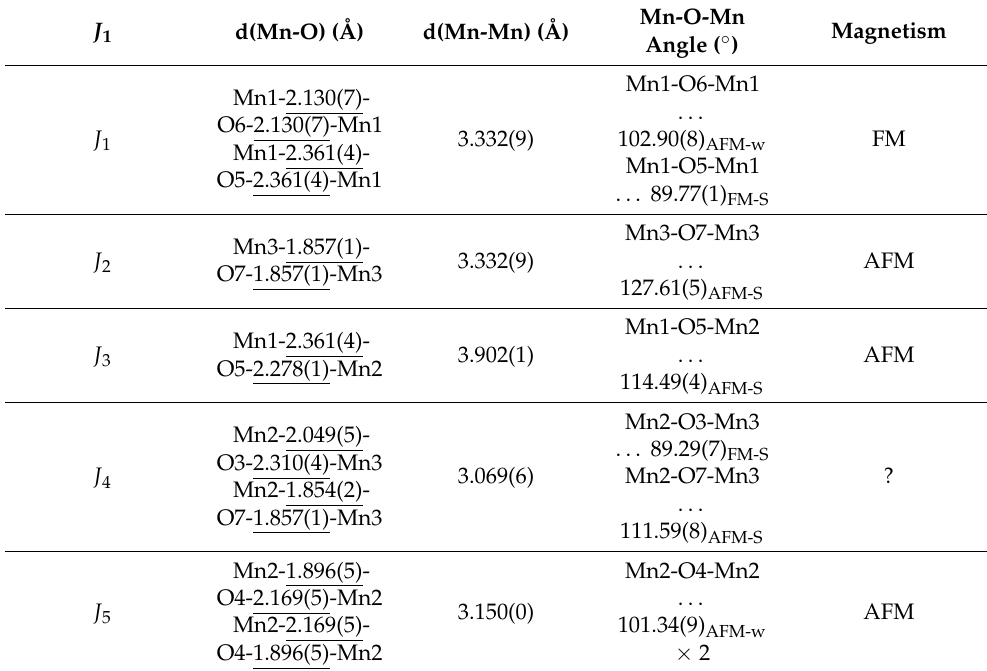
Table 1. Geometric parameters of dominant magnetic superexchanges in Mn 3 O(SeO 3 ) 3